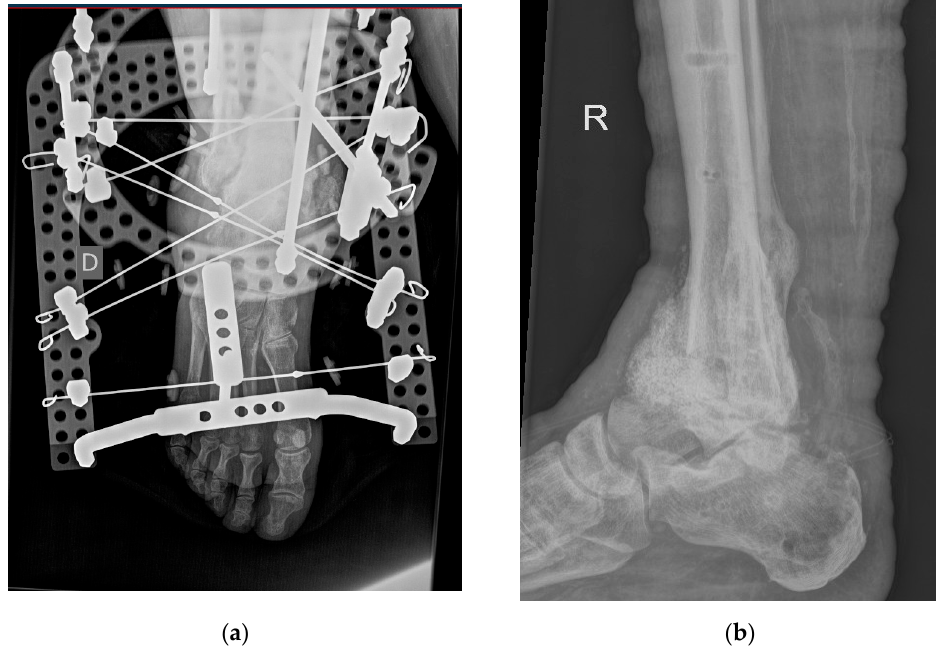
Figure 3. ( a ) Patient after insertion of bioactive glass granules and putty (malleolus) with an Iliza- rov external fixation device. Image captured with Siemens Polydoros SX80 ® (Siemens, Munich, Germany); ( b ) patient after removal of Ilizarov external fixation device (eight months after inser- tion of bioactive glass granules and putty). Image captured with Philips Digital Diagnost ® (Philips, Amsterdam, The Netherlands) (exposure parameters: 68 kv and 4 mAs).